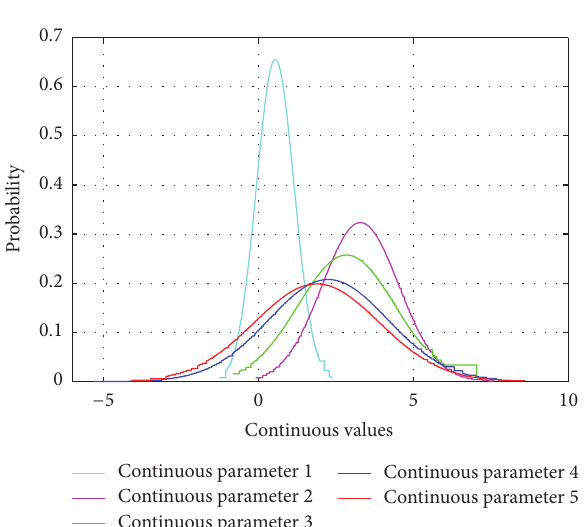
Figure 5: Statistical distribution of continuous parameters.